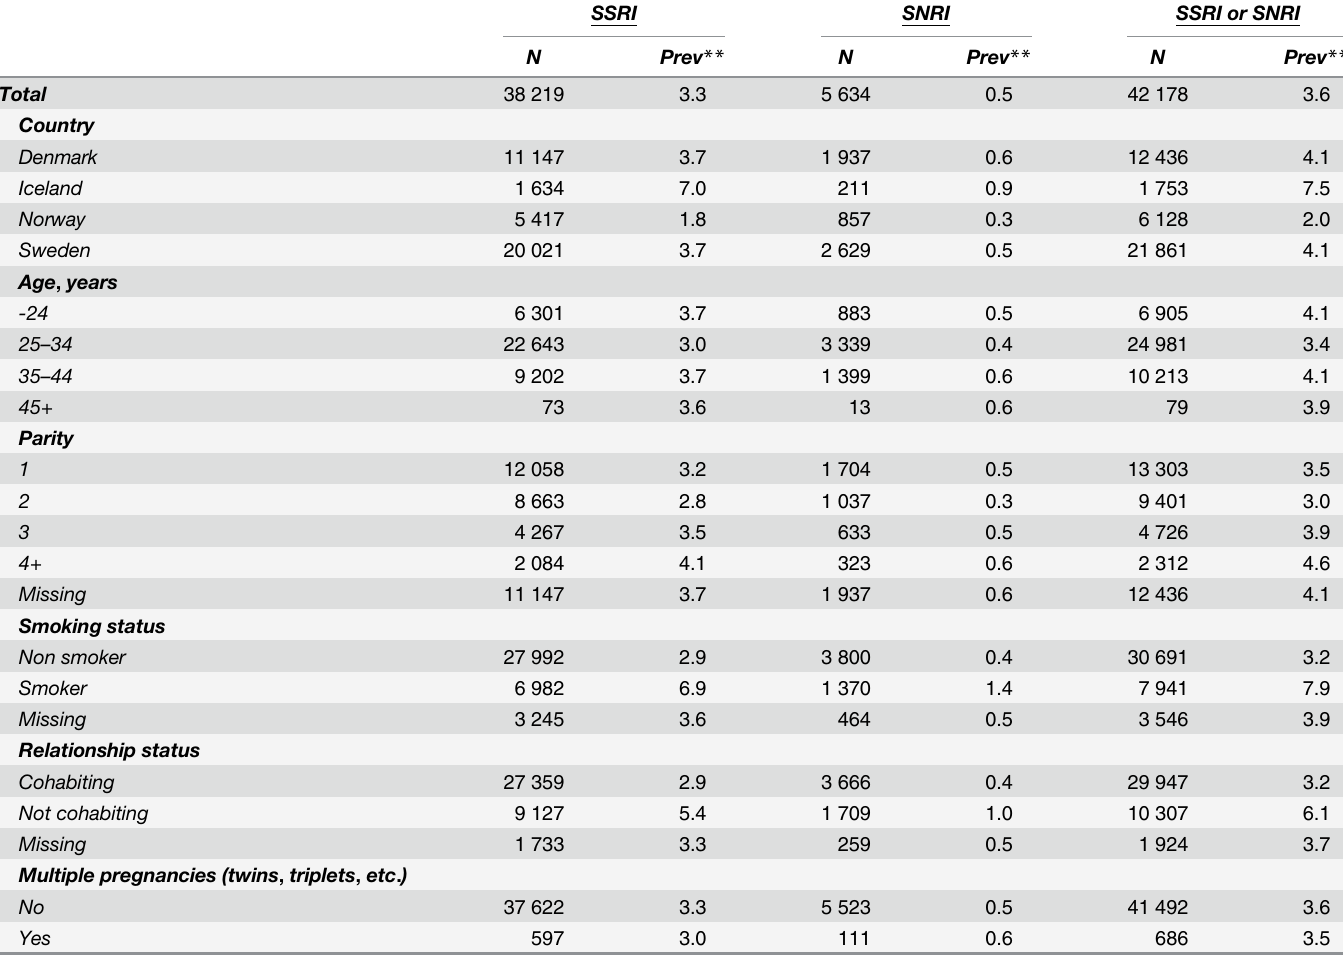
Table 1. Women exposed to SSRIs and SNRIs during pregnancy * by maternal characteristics, 2008 –